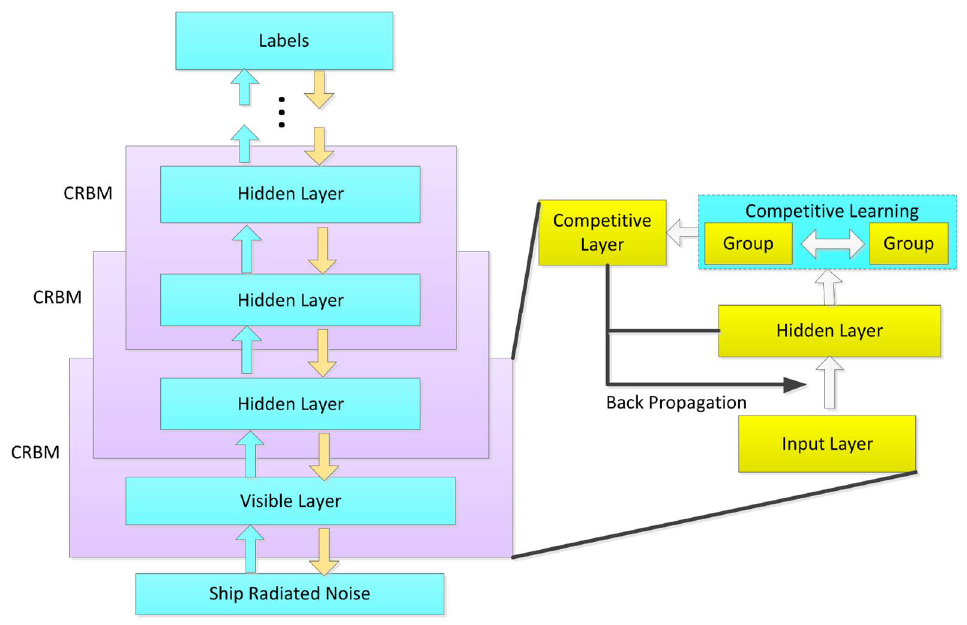
Figure 8. DBN structure used in [47].